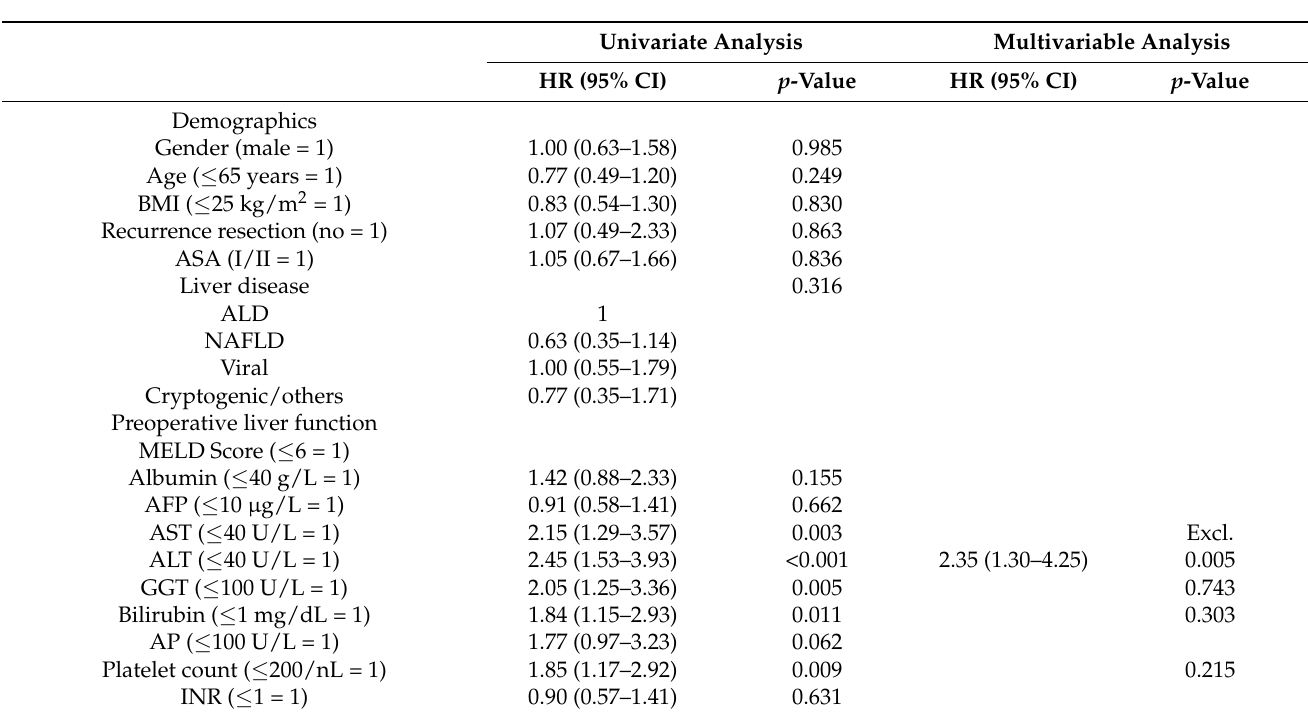
Table 3. Univariate and multivariable analysis of recurrence-free survival in hepatocellular carcinoma. Various parameters are prognostic for recurrence-free